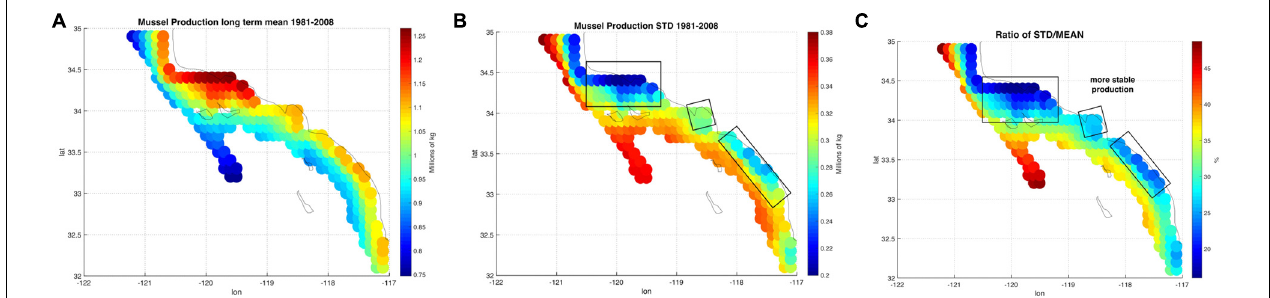
FIGURE 2 | (A) Long-term mean of production from the mussel model along in the Southern California Bight (SCB) at the 223 sites. (B) Standard deviation of mussel production. (C) Ratio between standard deviation and long-term mean of production expressed in percentage.